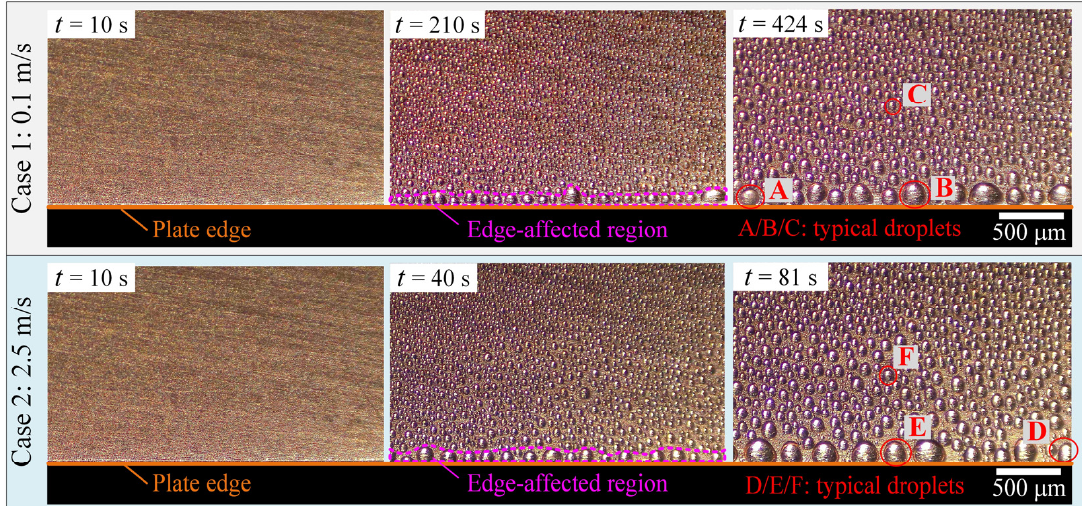
Figure 3. Top-view images of water droplet condensation characteristics.